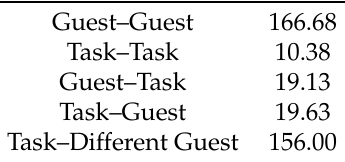
Table 2. Context-switch operation execution time ( µ